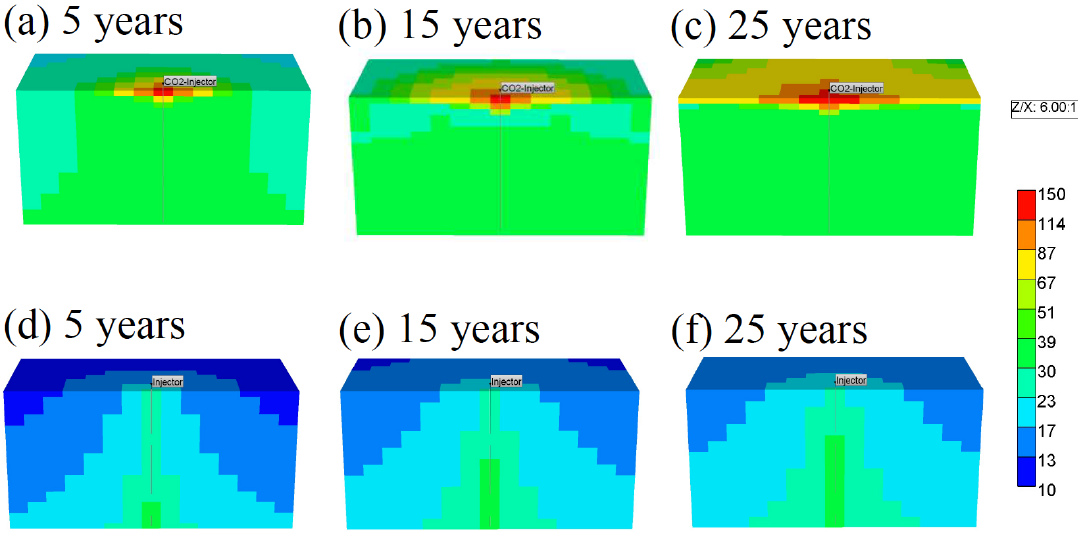
Figure 6. Base case simulations showing the pressure plume evolution around the wellbore and in the reservoir after 5, 15, and 25 years for equivalent mass injection of ( a – c ) CO 2 and ( d – f ) low-salinity water.